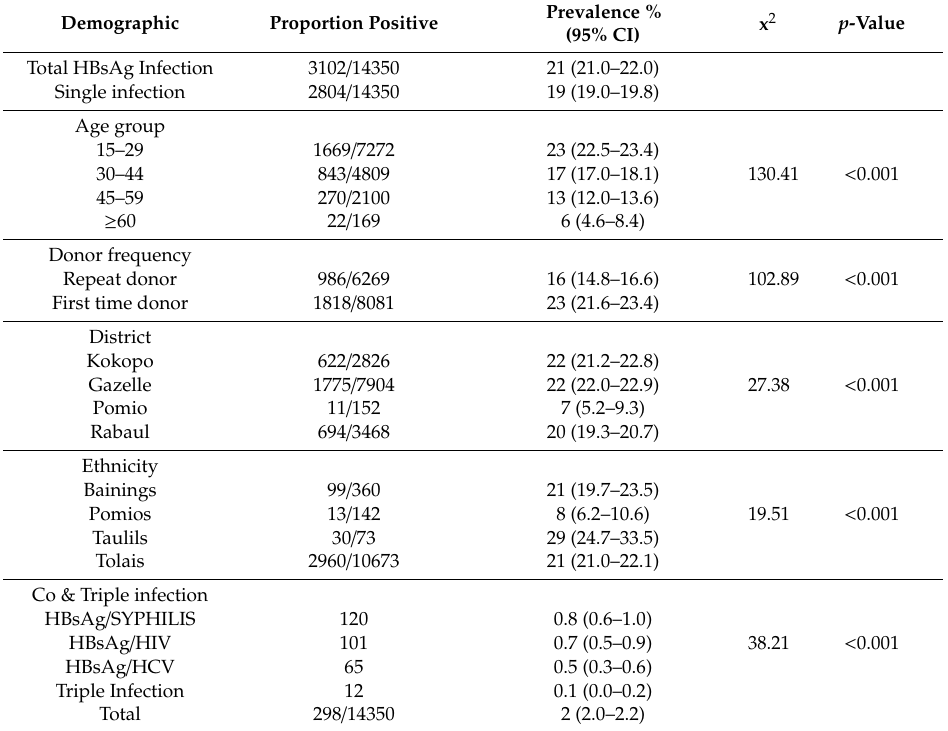
Figure 5. Proportion of HBsAg positive first time and repeat blood donors between 2003–2018.